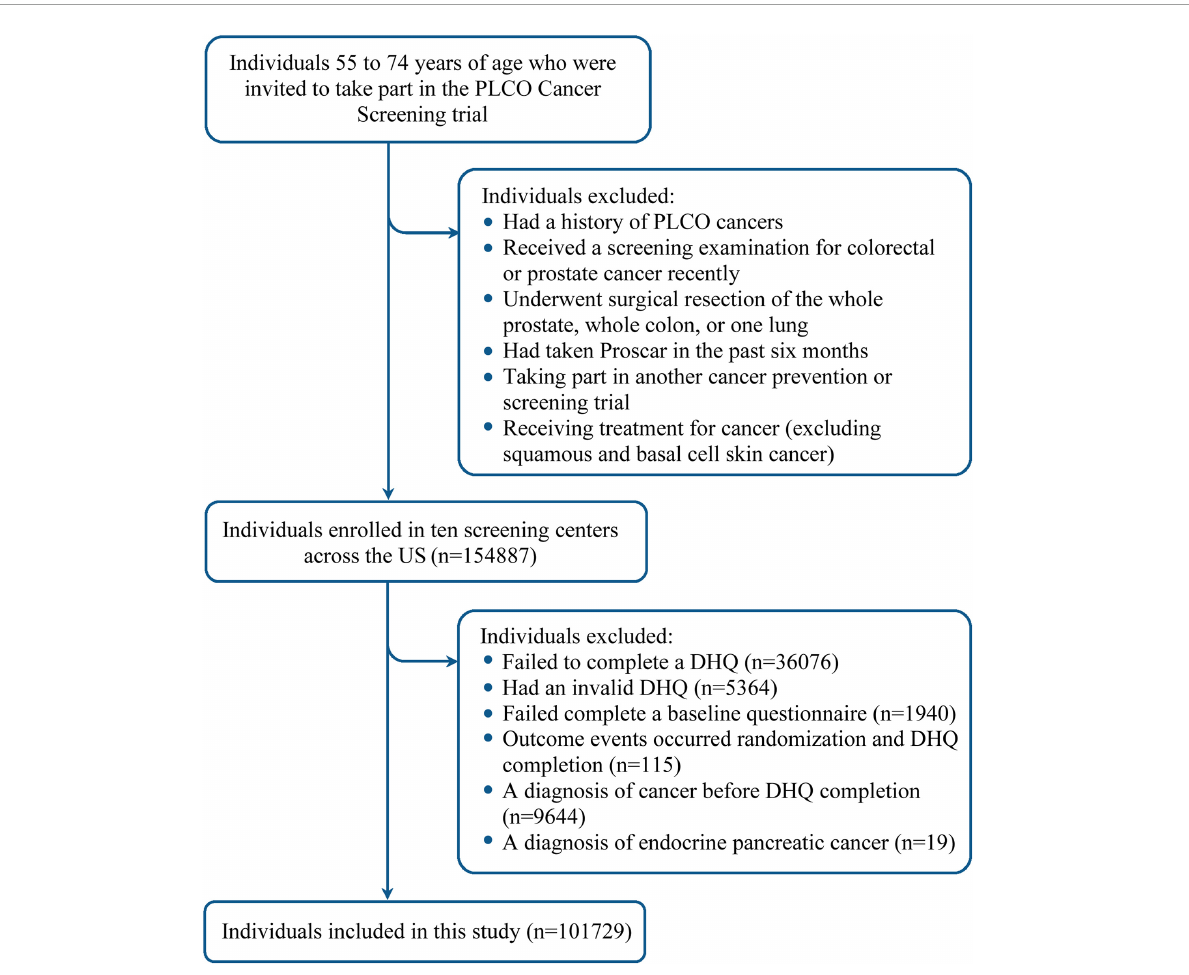
FIGURE1 Flow chart identifying participants included in this study. PLCO, Prostate, Lung, Colorectal, and Ovarian; DHQ, diet history